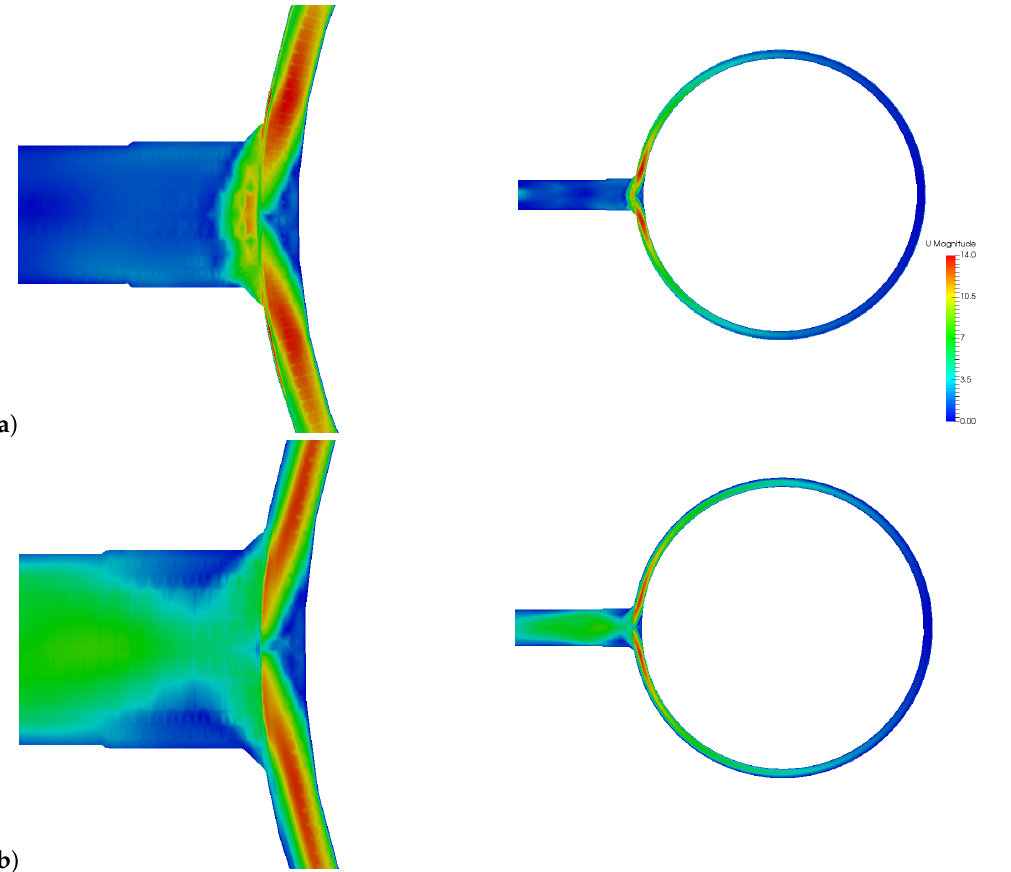
Figure 6. Velocity magnitude distribution for grooves 1 ( a ) and 2 ( b ) for position R12 with detail of junction with outlet port. Units of velocity are